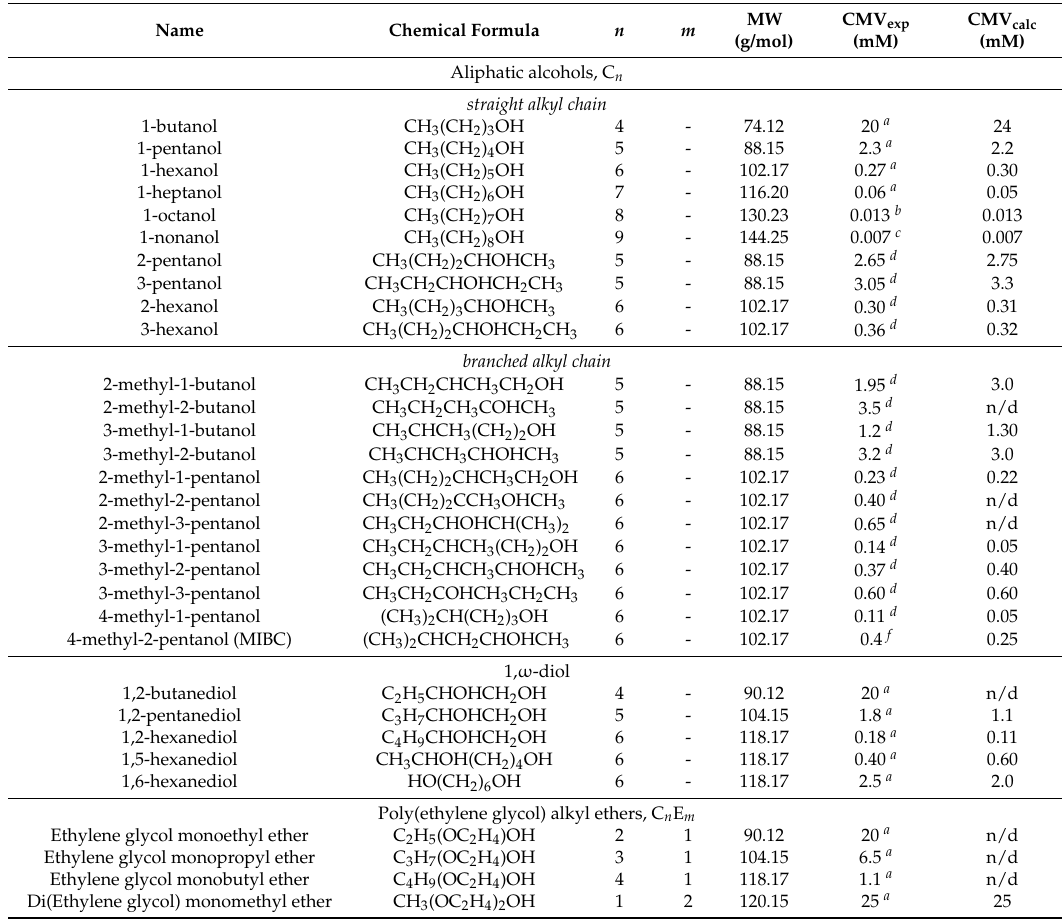
Figure 9 . Influence of n -alkyltrimethylammonium bromides (C n TAB), commercial and other frothers concentration expressed in mM ( a ) and normalized surfactant concentration ( c /CMV) ( b ) on the normalized terminal bubble velocity. Table 1. Properties of surfactants used in this study. Data from a [3], b [24], c [25], d [2], e [26], f [1], g [19]. Accuracy of CMV according to original source. n / d —not determined because original data were not available.